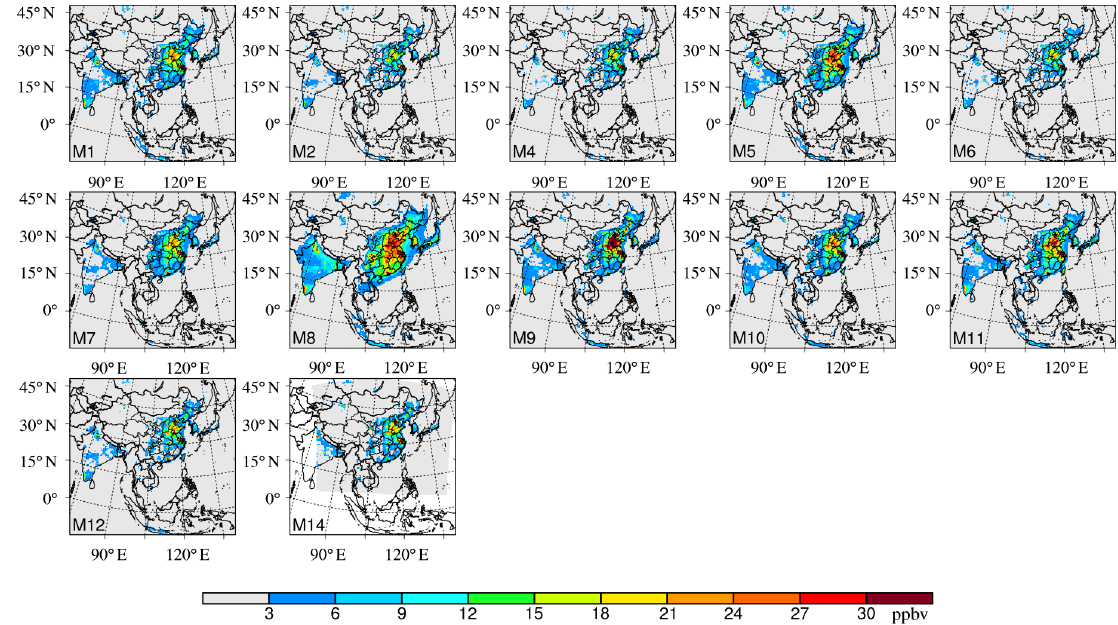
Figure 6. Spatial distribution of the annual mean NO 2 concentrations from each modeling result of MICS-Asia III. Note that M13 is not included in this figure.